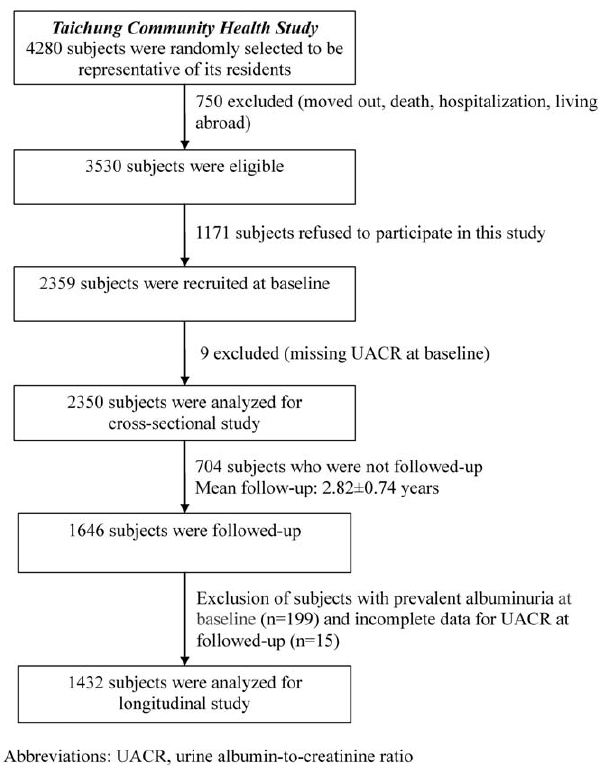
Figure 1. Taichung Community Health Study (TCHS) popula- tion